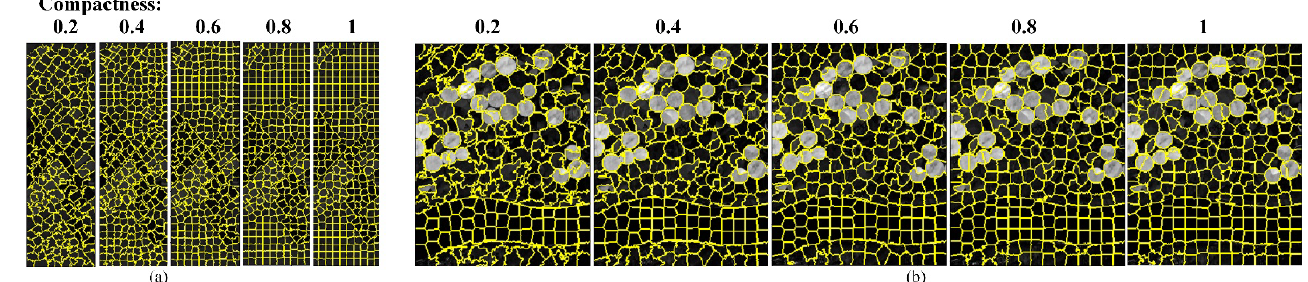
Figure 16. Superpixel segmentation with different compactness’s on ( a ) the China dataset and ( b ) the USA dataset.